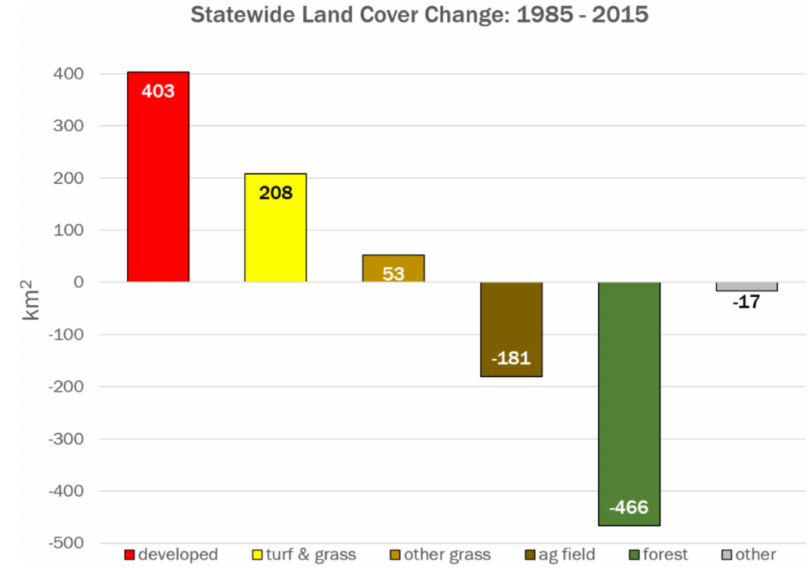
Figure 12. Statewide land cover change, 1985–2015 (km 2